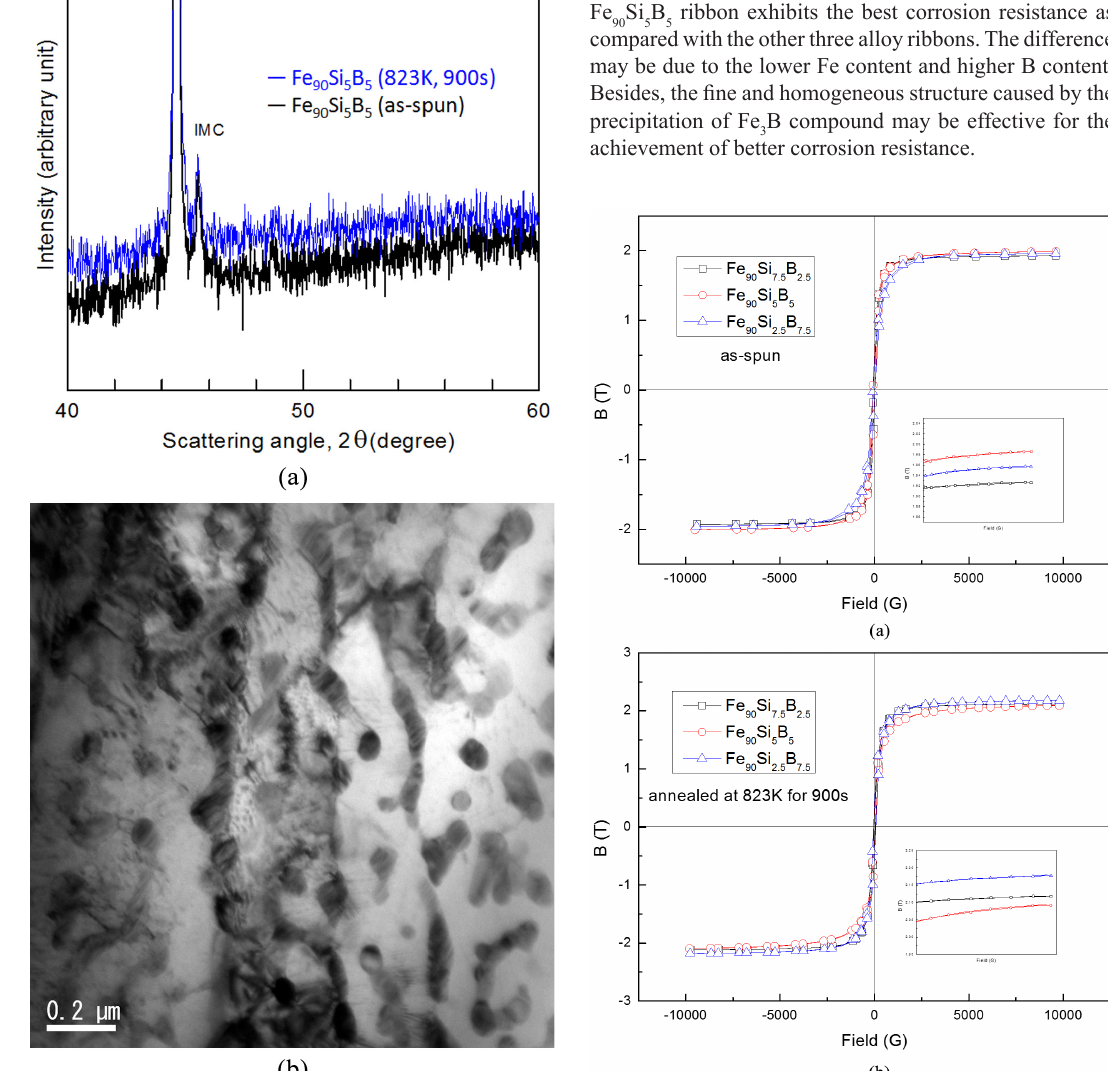
Si B , Fe Si B and 90 5 5 90 2.5 7.5